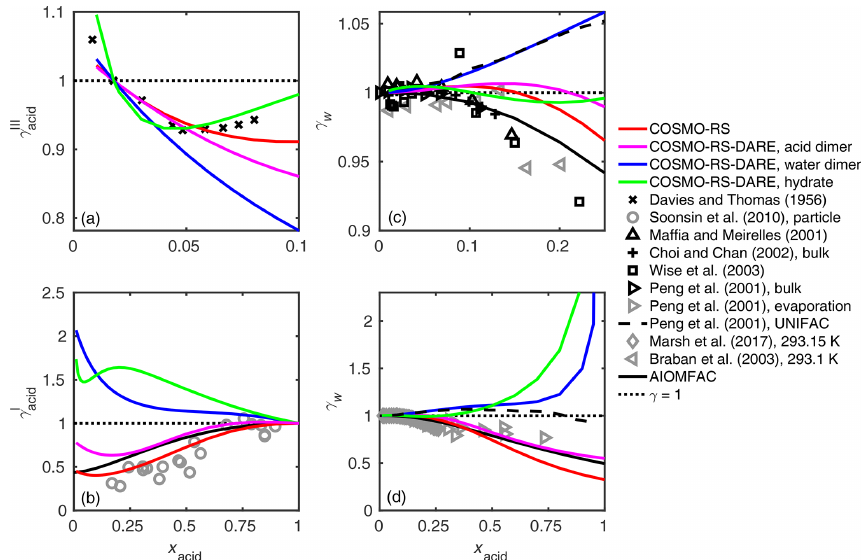
Figure 5. Activity coefficients of (a, b) malonic acid and (c, d) water in the binary mixtures at 298.15 K calculated using different clustering reactions in the COSMO-RS-DARE calculation. As a comparison are activity coefficients of malonic acid by Davies and Thomas (1956) (at 298.15K given in convention III) and Soonsin et al. (2010) (particle measurements at various temperatures given in convention I) and of water by Maffia and Meirelles (2001), Choi and Chan (2002), Wise et al. (2003), Peng et al. (2001), Marsh et al. (2017), Braban et al. (2003), and AIOMFAC-web